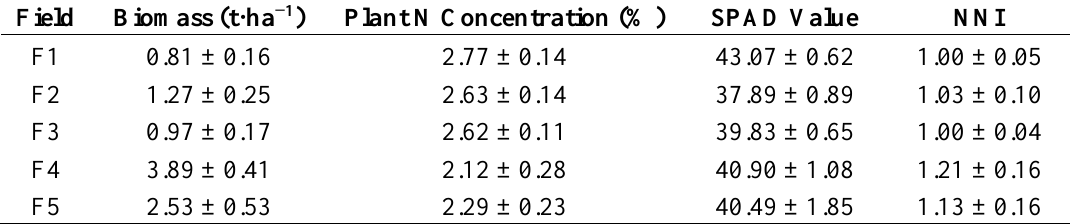
Table 4 . Descriptive statistics of rice N status indicators for different fields, Heilongjiang Province, China, 2011–2012. NNI stands for N Nutrition